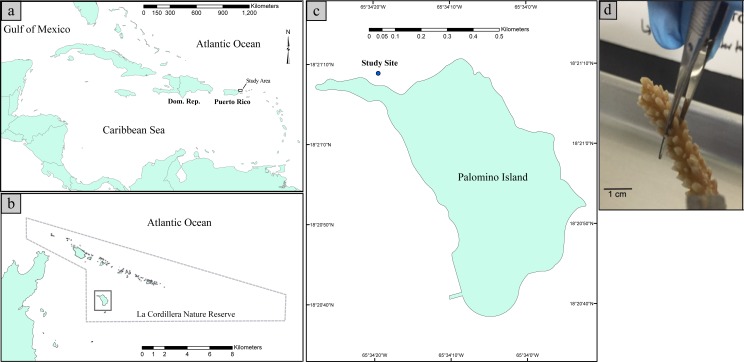
Map illustrating the geographic position of Puerto Rico in the Caribbean Basin (A). Map illustrating the study site with respect to La Cordillera Natural Reserve (B). Map illustrating the sampling site with respect to Palomino Island (18°21′10.8″N 65°34′24.4″W) (C). Picture of a collected fragment of Acropora cervicornis prior to DNA extraction (D).